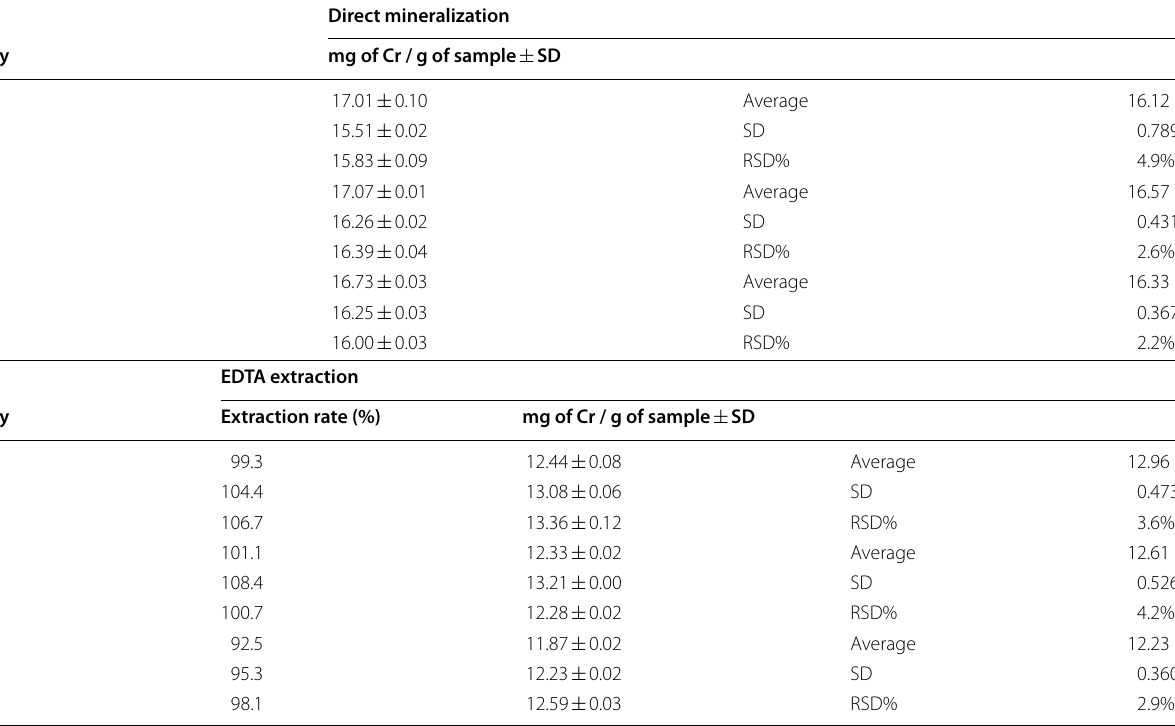
Table 4 Interday precision of: a direct mineralization; b EDTA extraction. 3 different samples were analyzed each day